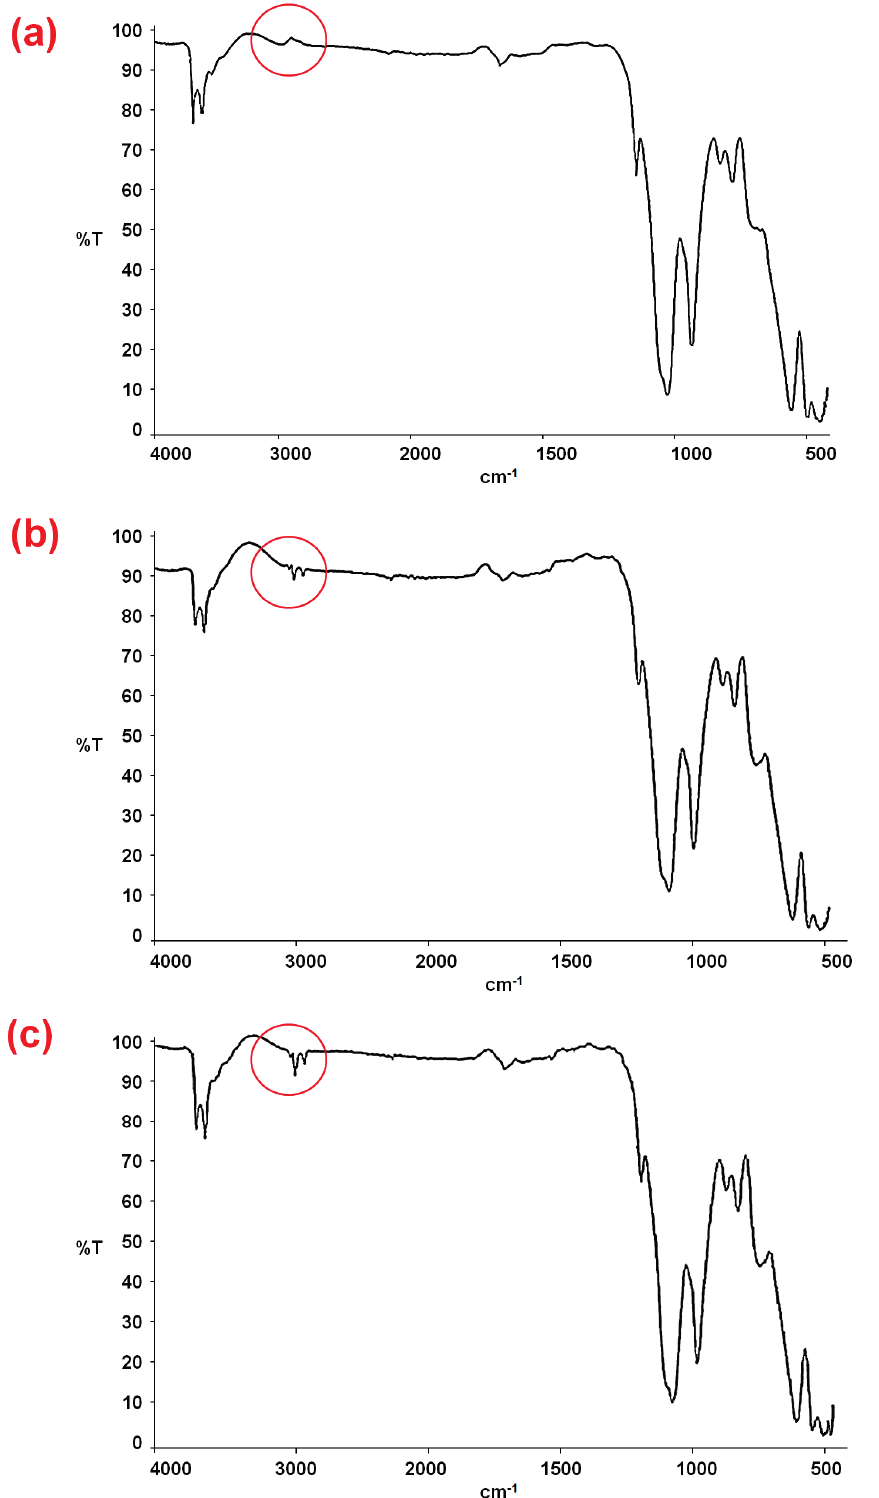
Figure 1. FTIR images of ( a ) HNTs; ( b ) HNTs–Trimethoxy(propyl)silane (TMPS); ( c ) HNTs–Triethoxy(octyl)silane